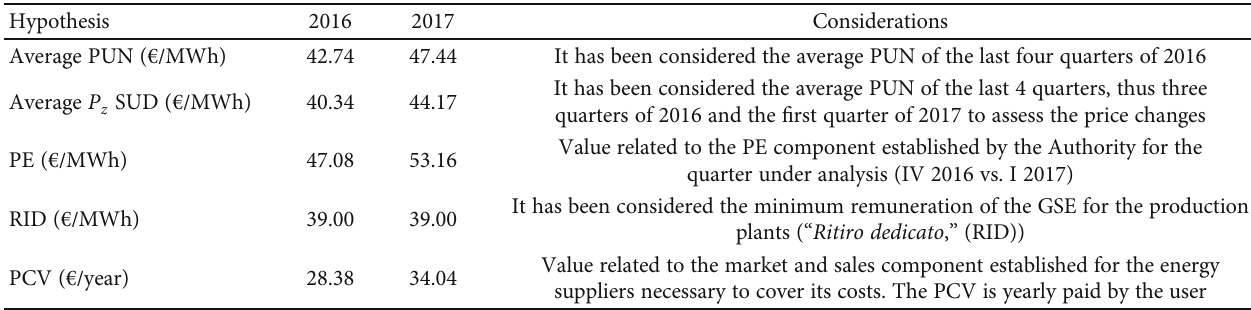
Table 2: Market prices 2016 vs. 2017.